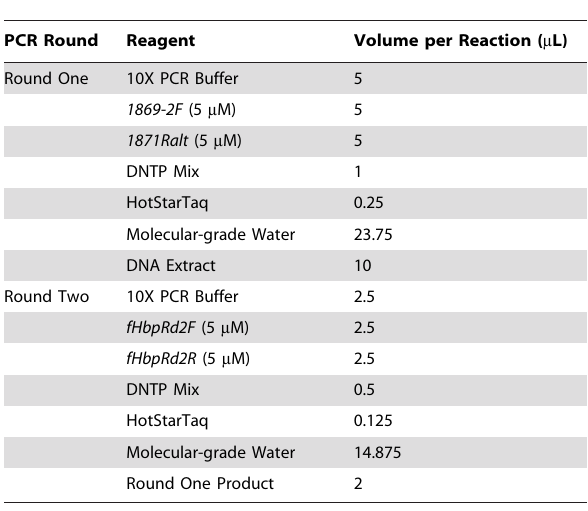
Table 3. Standard nested-PCR mastermix reagent